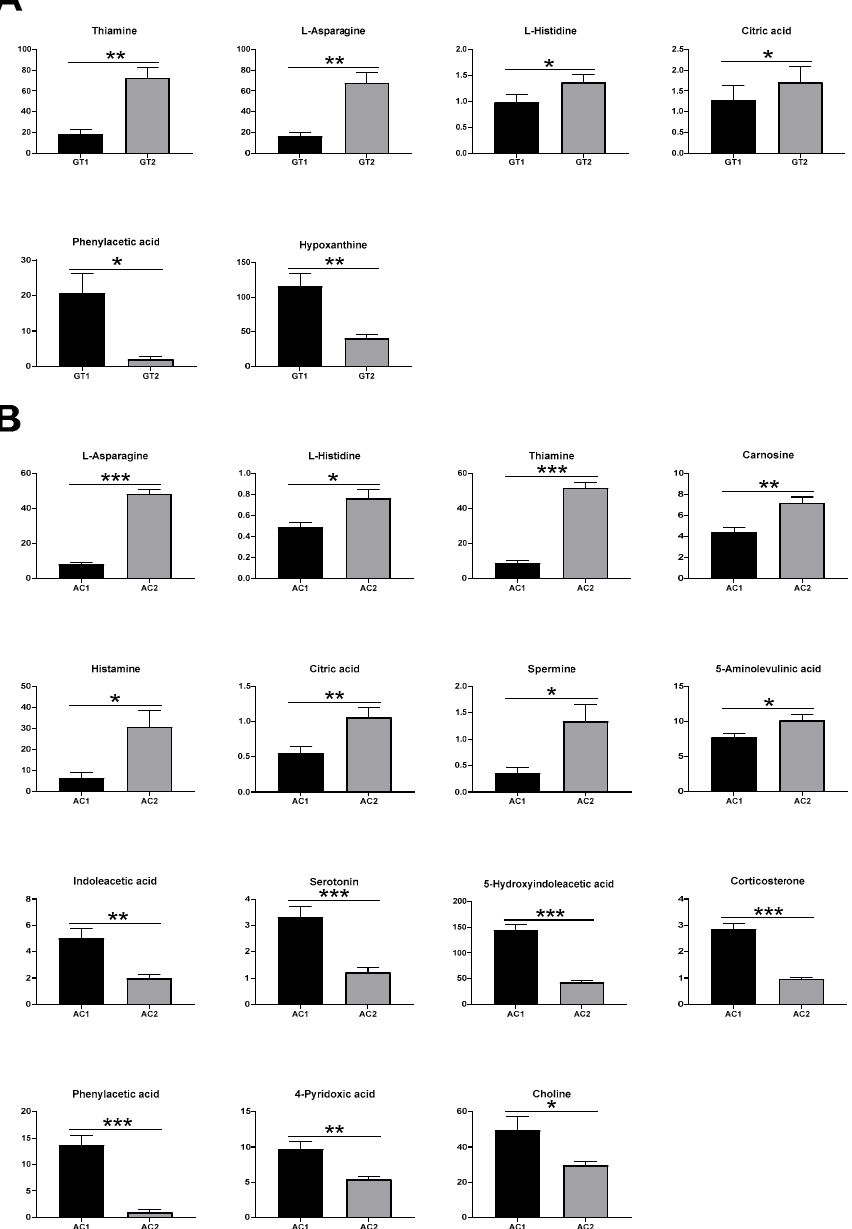
Figure 7. Boxplot of key metabolites of GT ( A ) and AC ( B ) groups. The p -values in ( A , B ) were analyzed by paired Student’s t -test and are presented as the means ± SE. GT1, before gradual transition, n = 6; GT2, after gradual transition, n = 6; AC1, before abrupt change, n = 7; AC2, after abrupt change, n = 7. * Significant difference between two groups (* p < 0.05, ** p < 0.01, and *** p < 0.001).